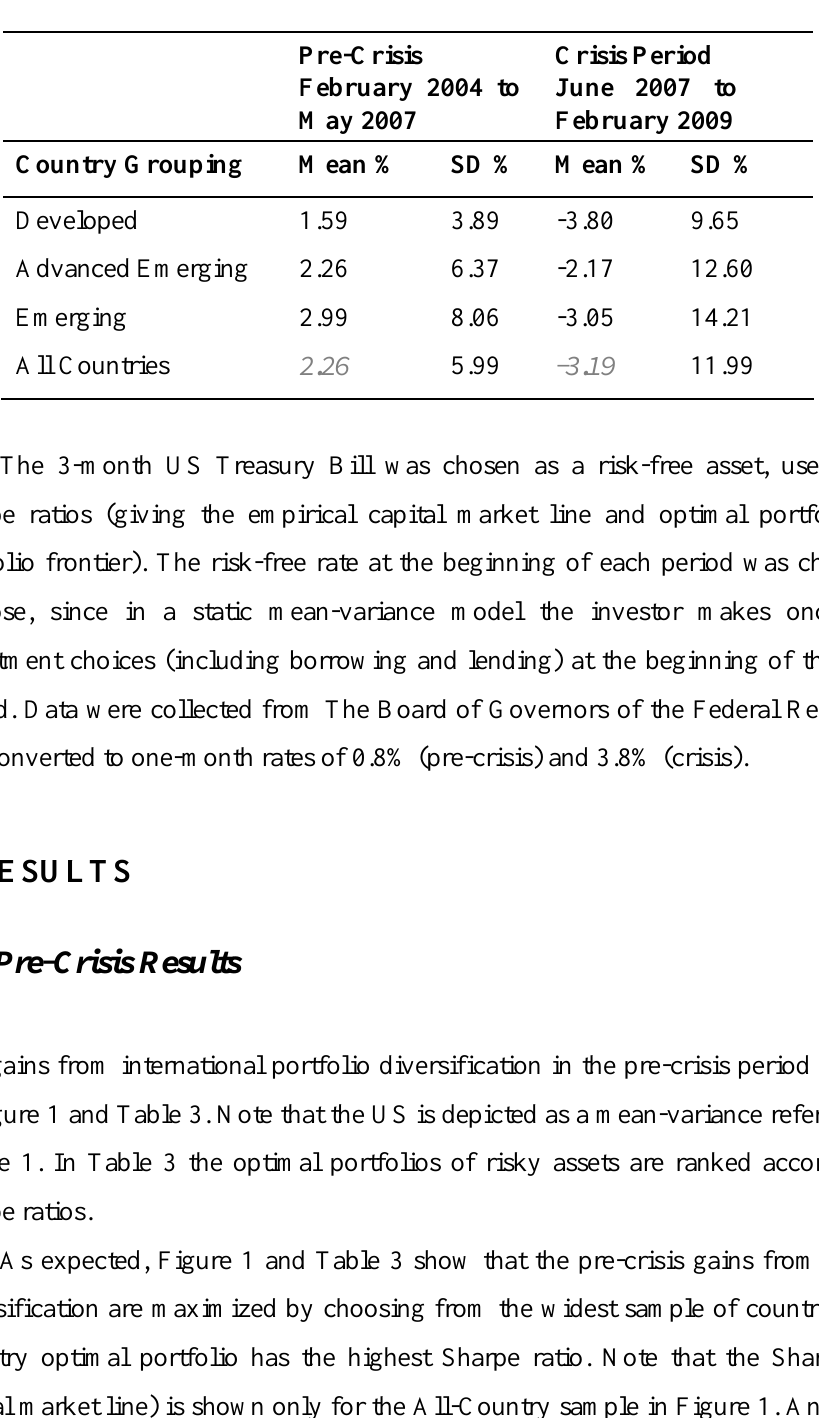
Table 2. Mean Returns and Standard Deviations for Country